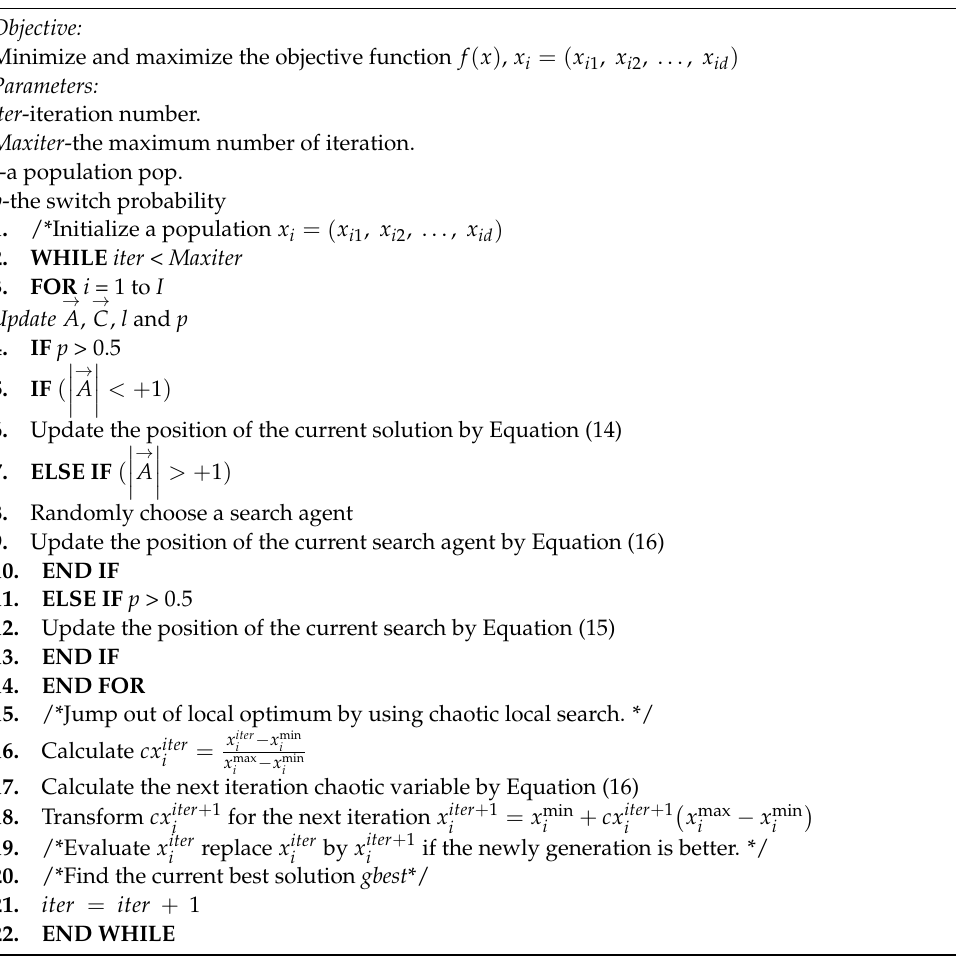
Algorithm: Improved whale-optimization algorithm